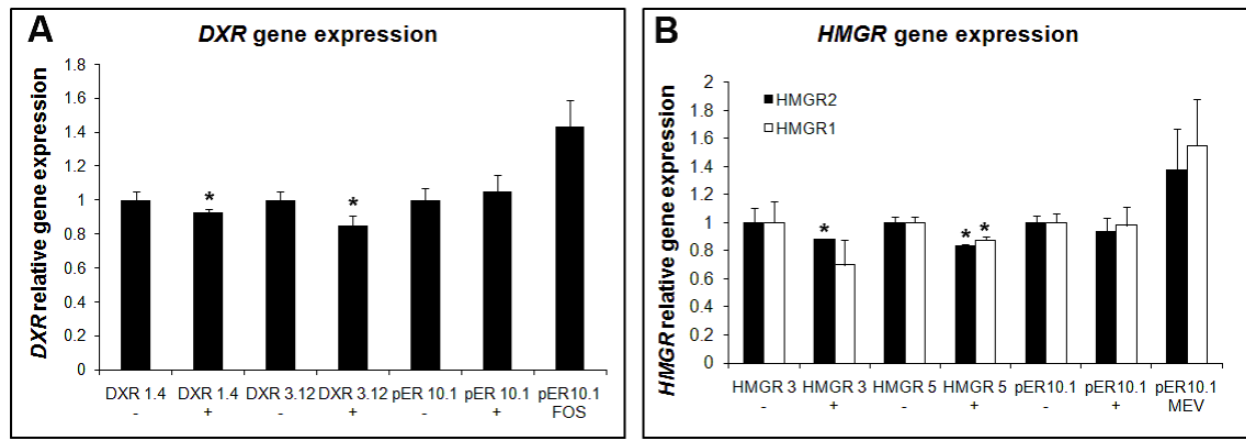
Figure 11. DXR and HMGR gene silencing via inducible amiRNA in BY-2 cells. Two Nicotiana tabacum BY-2 lines, independently transformed with inducible amiRNA constructs against DXR (DXR 1.4 and DXR 3.12) or �MGR (�MGR 3 and �MGR 5) were treated 1 day after sub-culture with (+) or without (-) 5 µM estradiol. Control lines were also treated with FOS or MEV. Gene expression levels for DXR ( A ), �MGR1 and �MGR2 ( B ) were measured by qPCR after 24 h of treatment. Experiments and measurements were repeated three times. Statistically significant changes are indicated (asterisk, p-values<0.05). Changes in expression in a BY-2 control line (transformed with the empty vector, pER10.1) are also shown.